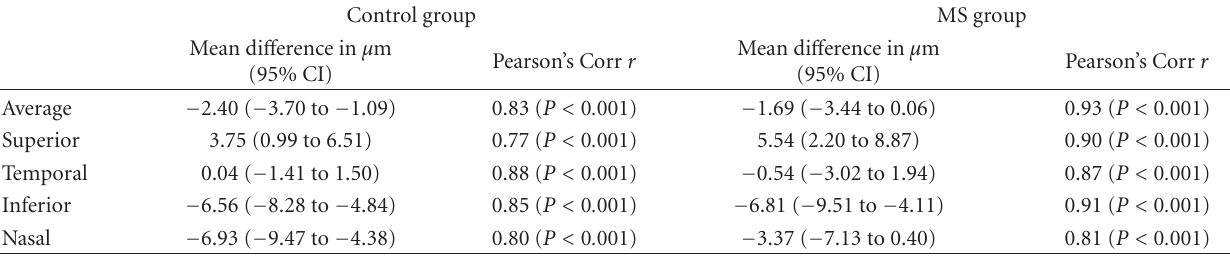
Table 2: Di ff erences in RNFLT between SD- and TD-OCT in MS group and control group (SD-OCT minus TD-OCT).